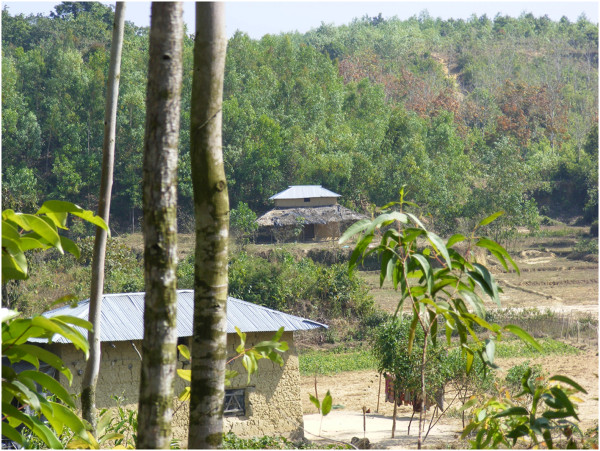
Pattern of the houses in Lama, Bandarban.